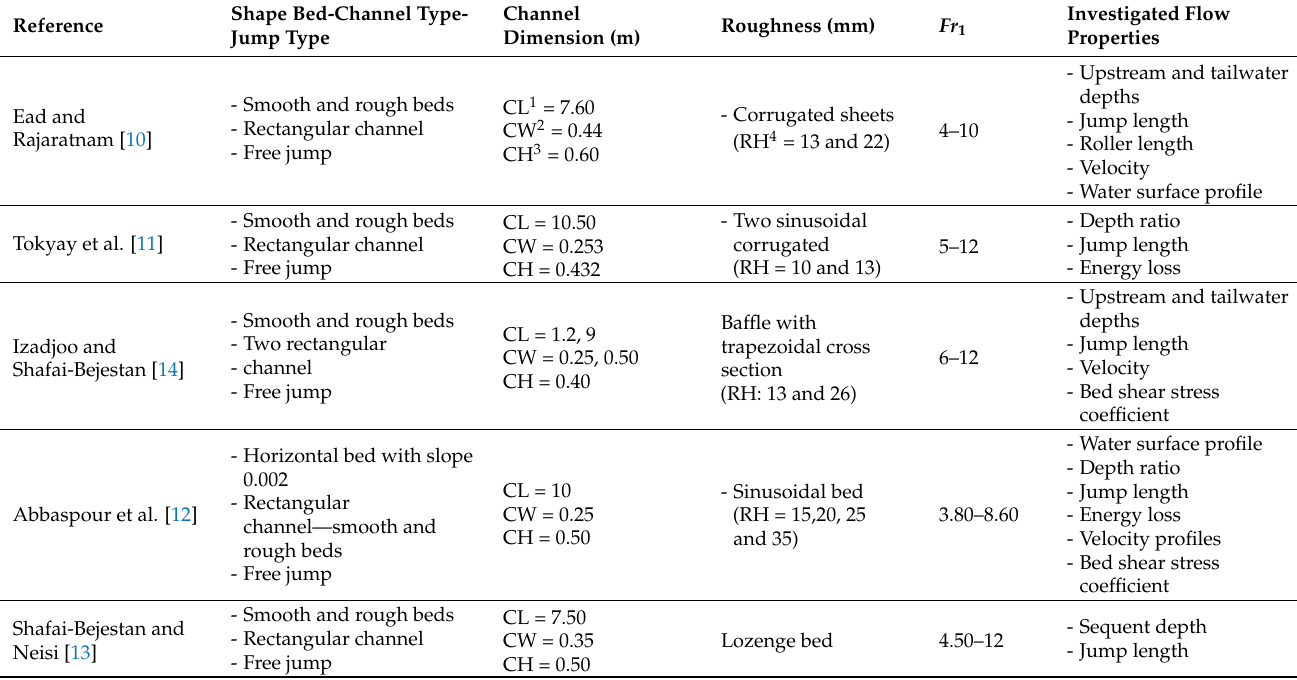
Table 1. Main characteristics of some past experimental and numerical studies on hydraulic